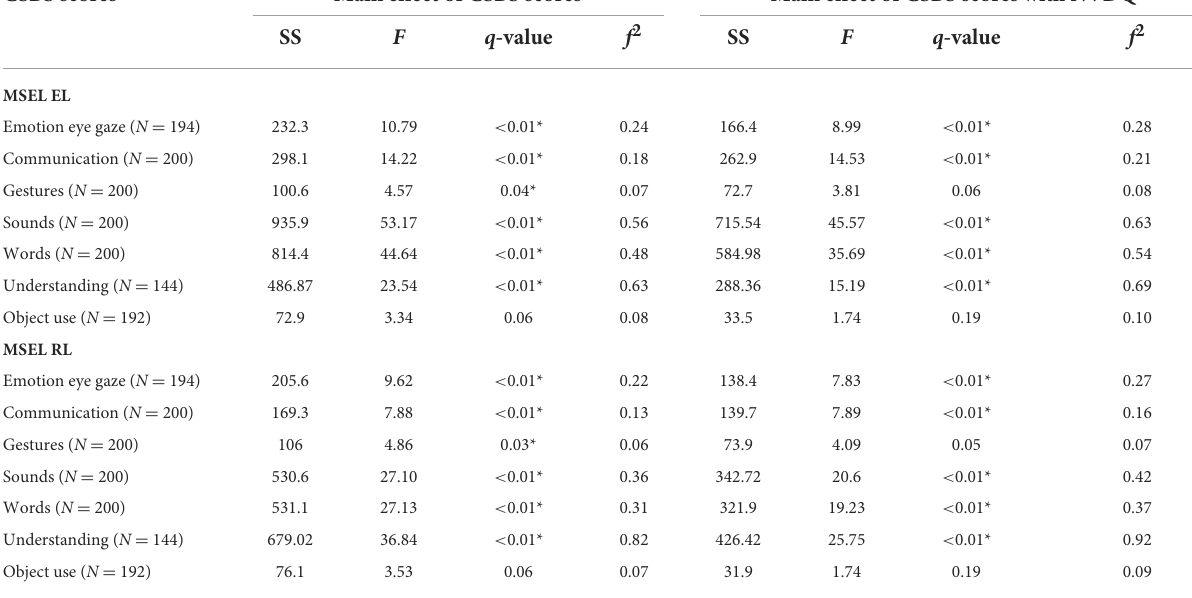
TABLE 6 General liner model exploring main effects of social communication skills measured at 24-months on language abilities measured at 36-months. CSBS scores